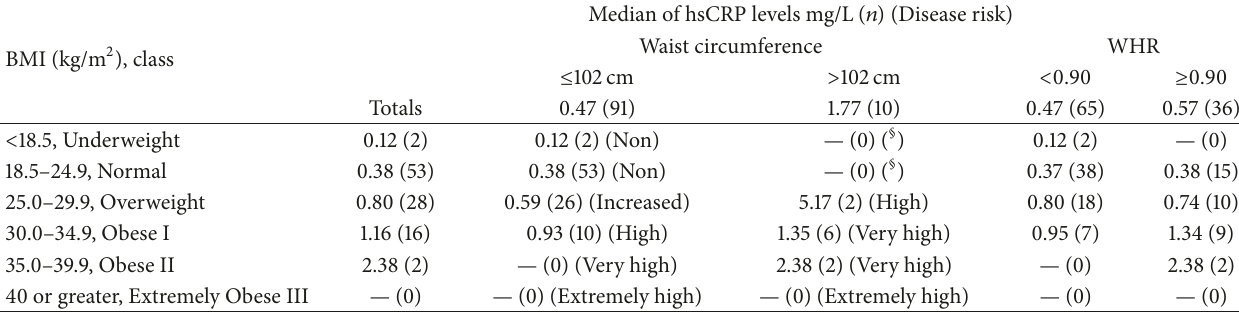
Table3:Participant’santhropometricmeasurementsgroupedbyBMI,waistcircumference[8]andWHR[10].MedianofhsCRPlevels(mg/L) and participant numbers (𝑛) of each group were shown (𝑛 = 101) . Disease risk ∗ of BMI and waist circumference were reported.